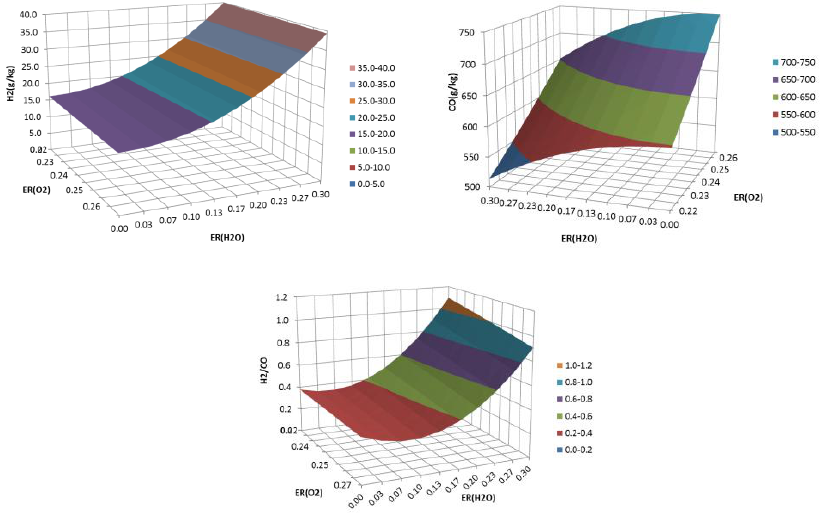
Figure 8. Yield of H 2 , CO and H 2 /CO ratio as function of the equivalence ratio ER(O 2 ) and ER(H 2 O) for almond shells.